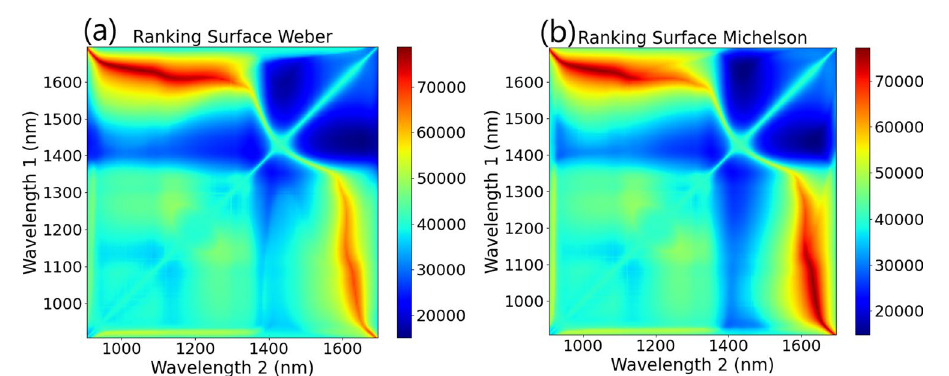
Figure 4. Ranking surface plots for ( a ) Weber contrast ratio and ( b ) Michelson contrast